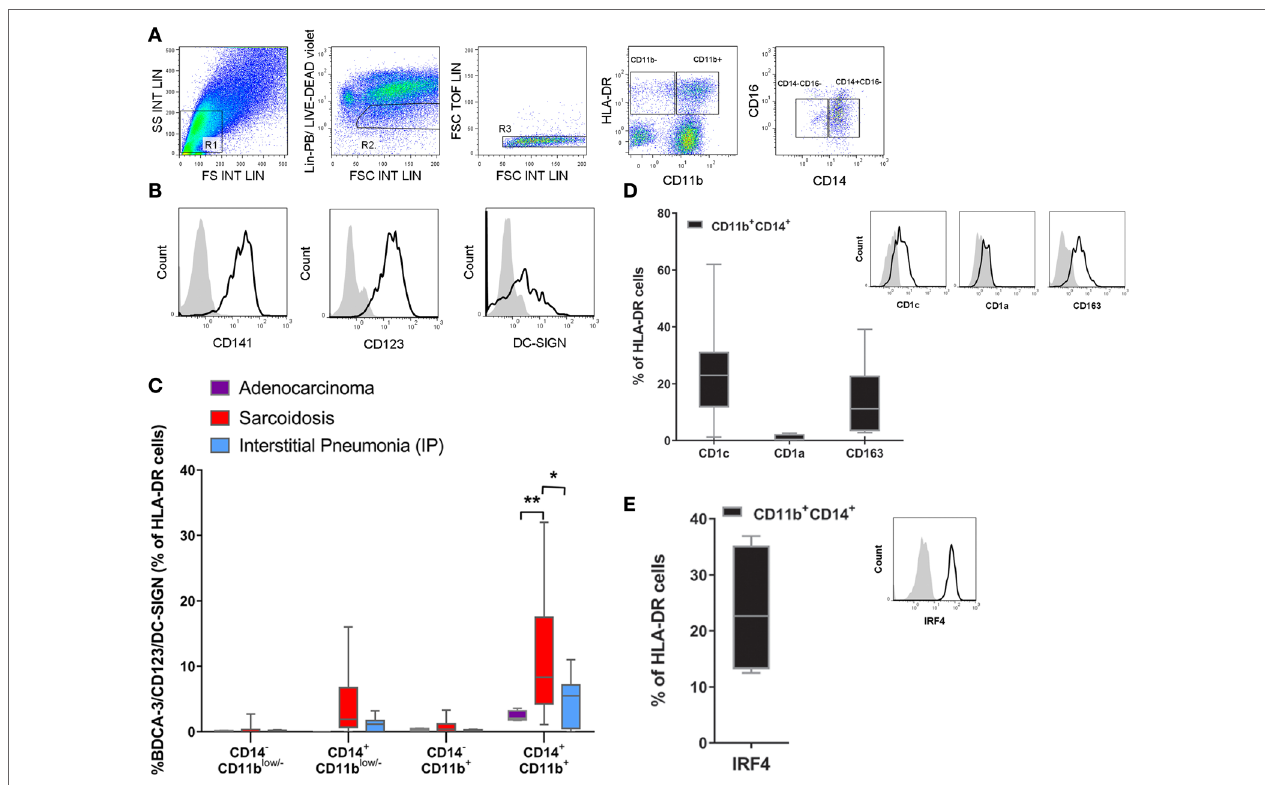
FigUre 8 | identification of the cD141/cD123/Dc-sign phenotype in bronchoalveolar lavage fluid (BalF) . Cells from BALF were obtained from patients with lung adenocarcinoma ( n = 4), sarcoidosis ( n = 13), or interstitial pneumonia ( n = 7). Cells were stained with anti-lineage (Lin) (CD3, CD19, CD 56), HLA-DR, CD11b, CD14, CD16, CD141, CD123, and DC-SIGN antibodies and analyzed by flow cytometry. (a,B) One representative experiment out of 13 samples from sarcoidosis patients is shown. Total cells were gated as depicted. From the FSC/SSC R1 gate, cells were gated into lin − and live cells (R2) and doublets exclusion (R3). Then cells were gated by HLA-DR expression and further selected by CD11b expression. (B) Histograms display the expression of the surface molecules CD141, CD123, and DC-SIGN of the gated population Lin − , HLA-DR + , CD11b + , CD14 + , and CD16 − in a sarcoidosis patient compared with the corresponding isotype control. (c) Percentage of the triple-positive CD141/CD123/DC-SIGN population among Lin − HLA-DR + and subsequent analysis in CD11b and CD14/CD16 gates. Data are depicted in box-and-whisker graph (* P < 0.05, ** P < 0.01). Statistical analysis was performed using Two-way analysis of variance test (followed by Tukey multiple comparisons test). (D,e) Cell percentage and representative histograms of CD1c, CD1a, CD163, and intracellular IRF4 in the Lin − HLA-DR + CD11b + CD14 + CD16 − population. Data are expressed as means ± SEM of at least four BALF with